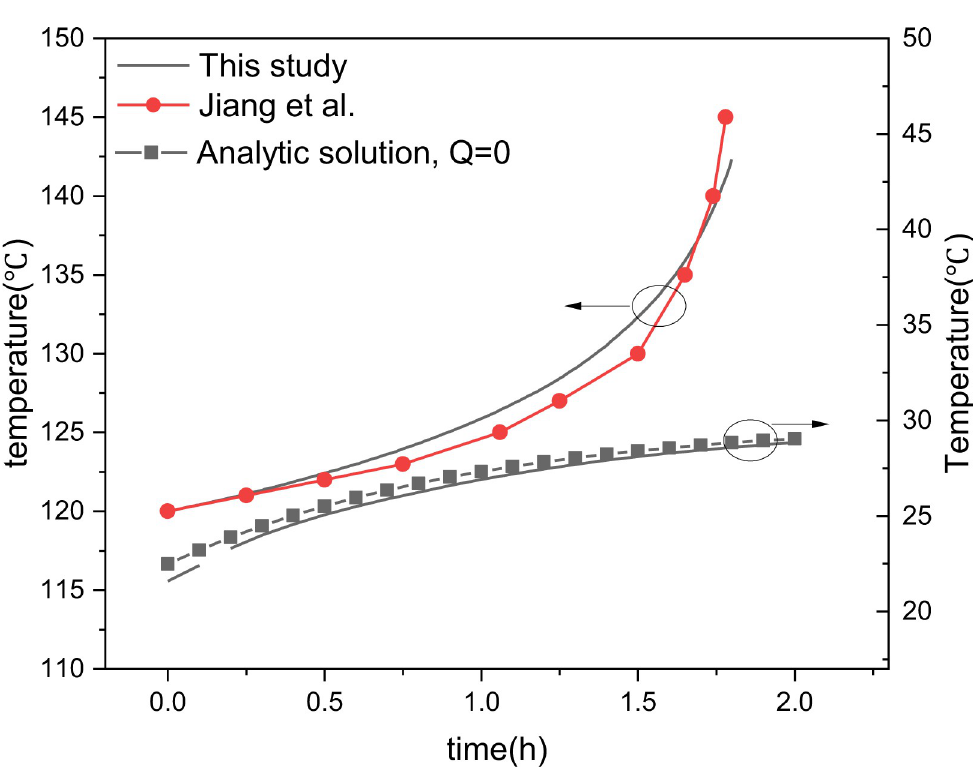
Fig 7. Verification of the coupled flow and convective heat transfer